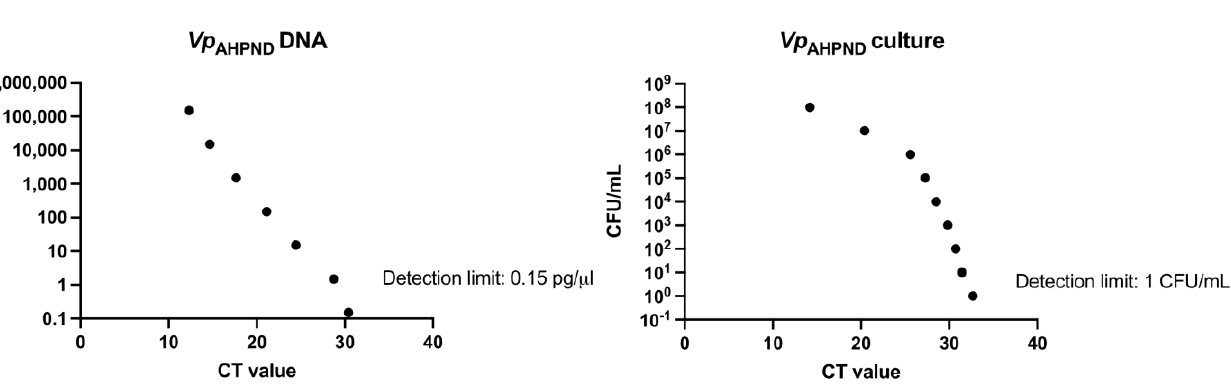
Figure 2. Vp qPCR sensitivity and detection limit. Vp qPCR sensitivity was tested using both purified DNA and bacterial cells and the detection limits were established. The figure shows the standard curves built from the CT values obtained in Vp qPCR of samples with different concentrations of DNA (left) and bacterial cells (right) of the Vp AHPND strain.